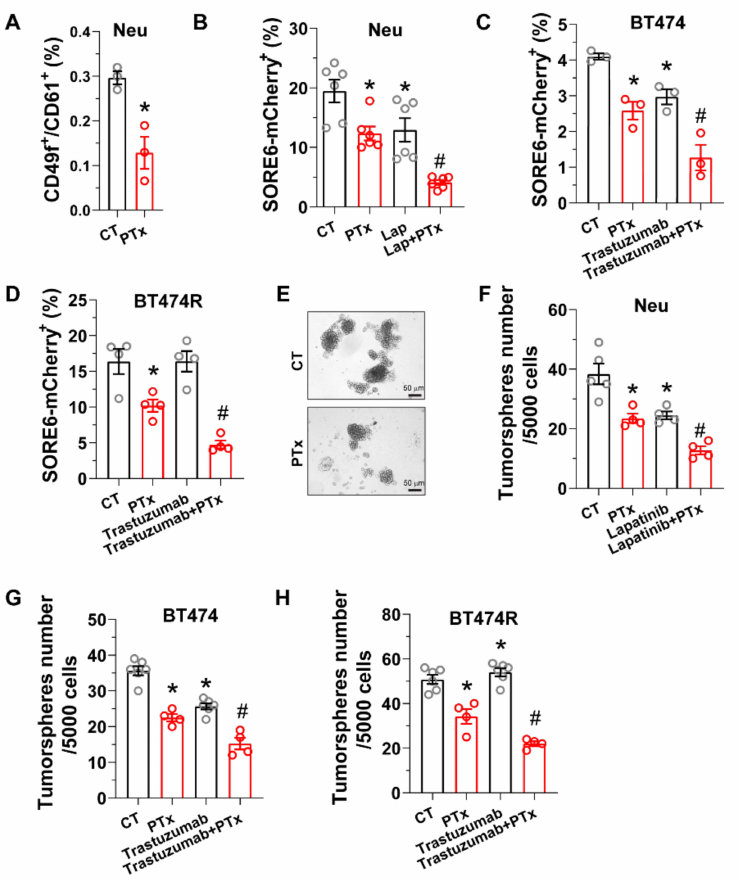
Figure 4. Gi/o GPCR signaling regulates the sensitivity of breast CSCs to HER2-targeted therapy. Neu, BT474, and BT474R cells were treated with PTx (0.2 µ g/mL), trastuzumab (1 µ g/mL), and lapatinib (1 µ M), either alone or in combination. The effect on ( A – D ) CSC populations was determined via flow cytometry; ( E – H ) tumorsphere formation was determined via tumorsphere-formation assays. ( E ) Representative images of tumorspheres for Neu cells. * p < 0.05 vs. CT, n = 3–6. # p < 0.05 vs. PTx, lapatinib, or trastuzumab alone, n =